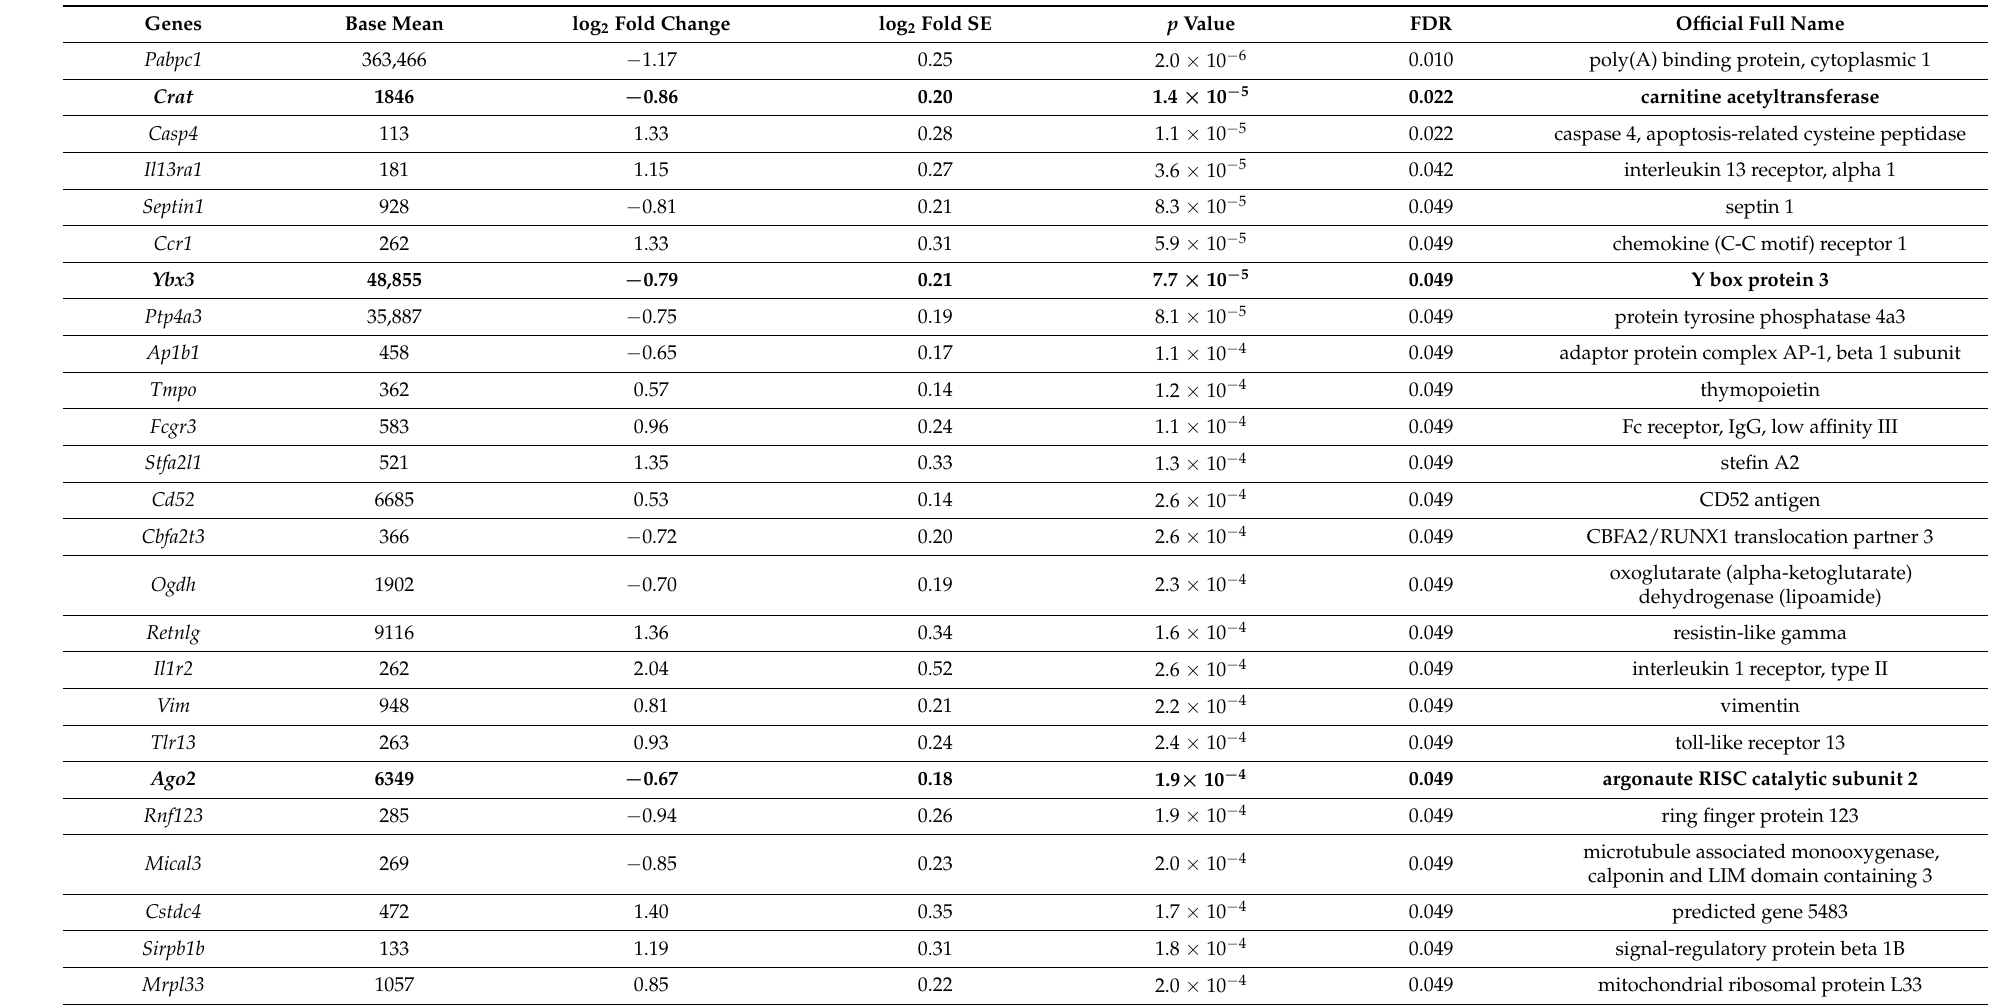
Table 4. List of 25 genes significantly modulated by tDCS in 3xTg-AD